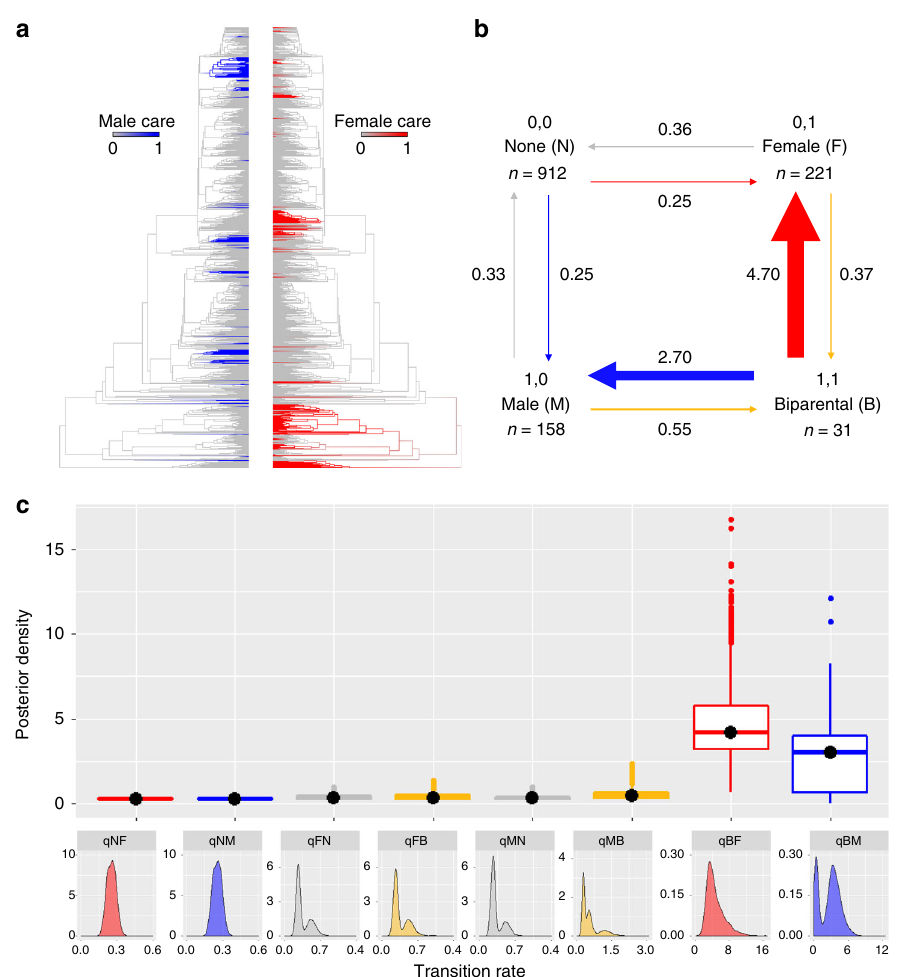
Fig. 4 The correlated evolution of male and female care. a Male care (blue) and female care (red) plotted on the phylogeny using stochastic character mapping with the R package phytools 73 . b Summary diagram of the transition rates across the four combinations of character states from the RJ Discrete Dependent model of evolution. The sample sizes for each combination of character state are reported; the arrows are scaled to re fl ect the magnitude of mean transition rates with the mean value also indicated. c Posterior distributions of the transition rates from the RJ Discrete Dependent model of evolution are shown as box plots for comparison and as posterior density plots for each transition rate alone. The central black dot in the box plots indicates the median, the box the upper and lower quartiles, the vertical lines the 95% credible intervals of the posterior distributions, and the fi lled dots beyond the lines indicate outlier estimates. Transition rates among character states in b and c are indicated as follows: no care to female only care (NF, red); no care to male only care (NM; blue); female only care to no care (FN; grey); female only care to biparental care (FB; yellow); male only care to no care (MN, grey); male only care to biparental care (MB; yellow); biparental care to female only care (BF; red); biparental care to male only care (BM;